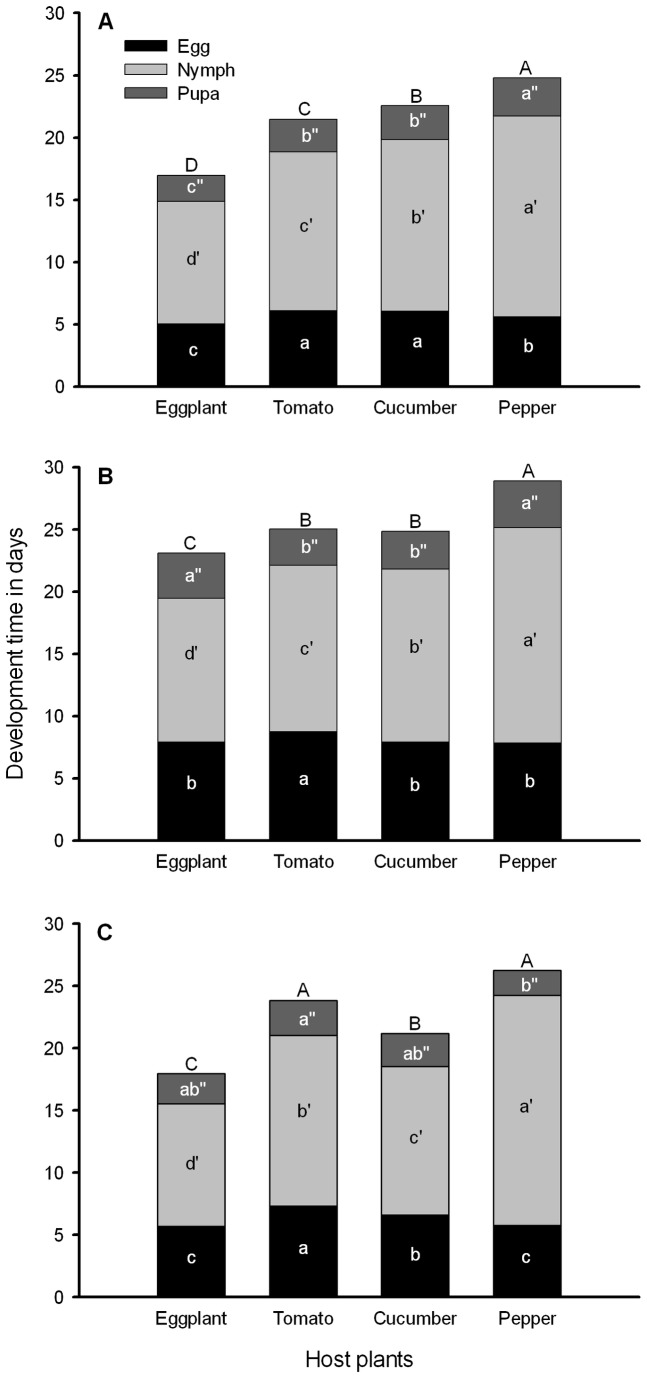
Development time (days ± SE) of B. tabaci immatures reared on four host plants.The bold A, B and C symbolized as immatures of Bemisia-eggplant, Bemisia-tomato, and Bemisia-cucumber, respectively. The regular A, B, C and D above the column symbolized for significant differences of overall development time among immatures on different host plants at P ≤ 0.05 (LSD). The letter on the columns a, b, c and d; a´, b´, c´ and d´; a", ab", b" and c" indicate significantly difference of the development time among of egg, larval and pupal stages, respectively, at P ≤ 0.05 (LSD).